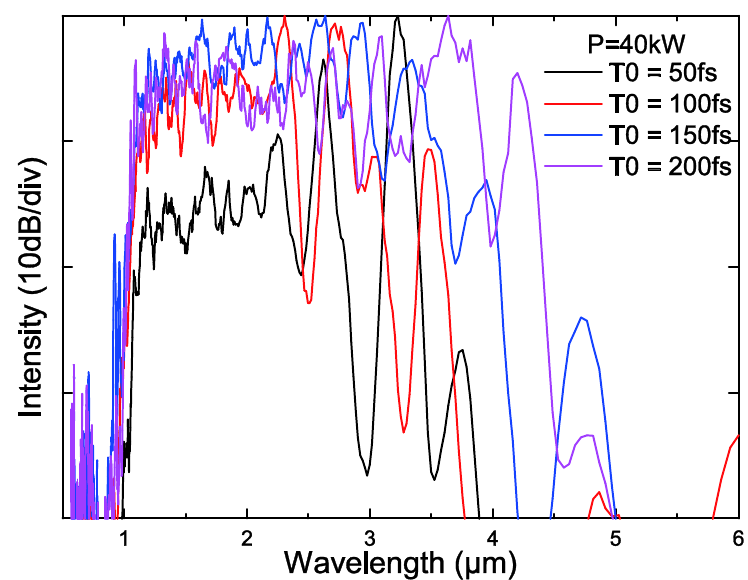
Figure 13. Simulated evolution of SCG pumped at di ff erent pulse durations with a pump power of 40 kW.